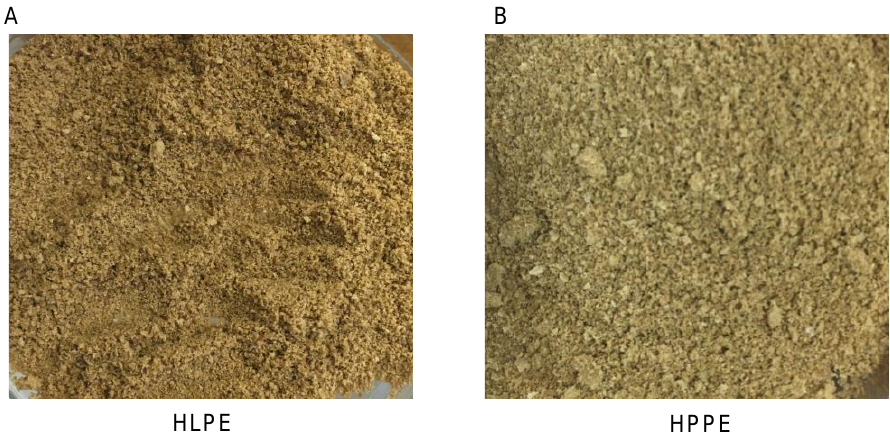
Figure 2. Images of the Huhu larvae (HLPE) ( A ) and pupae (HPPE) ( B ) protein extract powders. Table 3. Techno-functionality and physiochemical characteristics of the Huhu larvae and pupae protein extract powder suspensions.